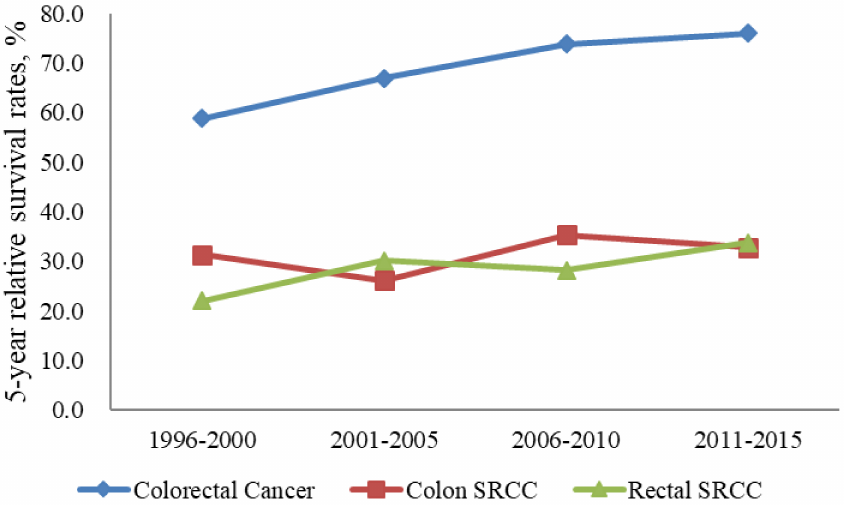
Figure 6. Five-year relative survival rate of all colorectal cancer and SRCC from 1996 to